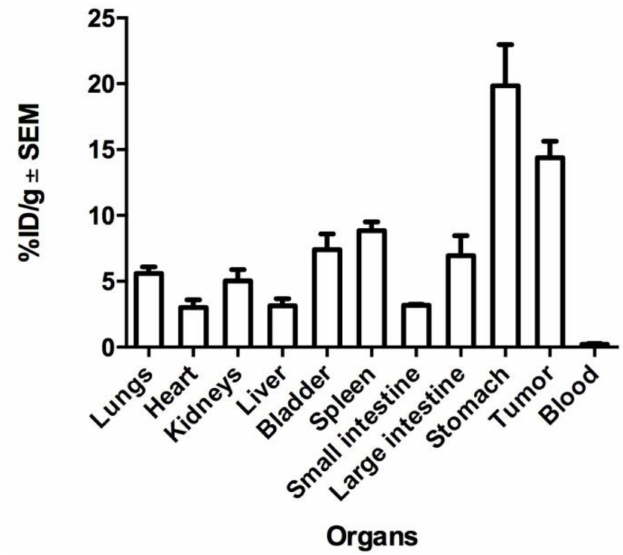
Figure 5. Biodistribution profile of 67 Ga-nimotuzumab in the tumor and organs of interest at 48 h. Values represent the mean ± SEM ( n =